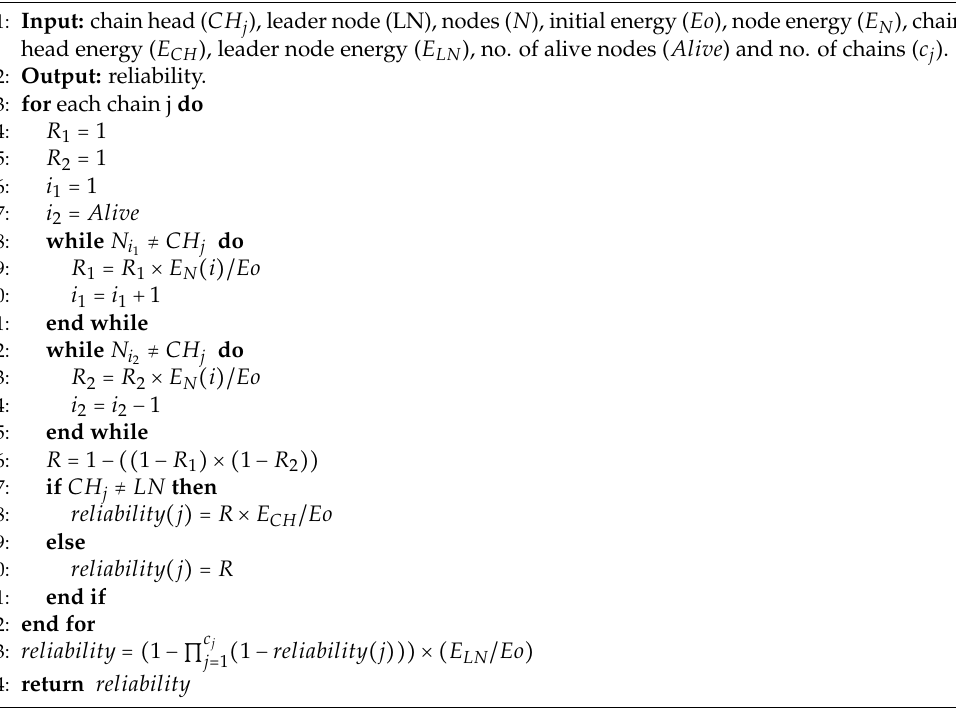
Algorithm 6 Calculate reliability of